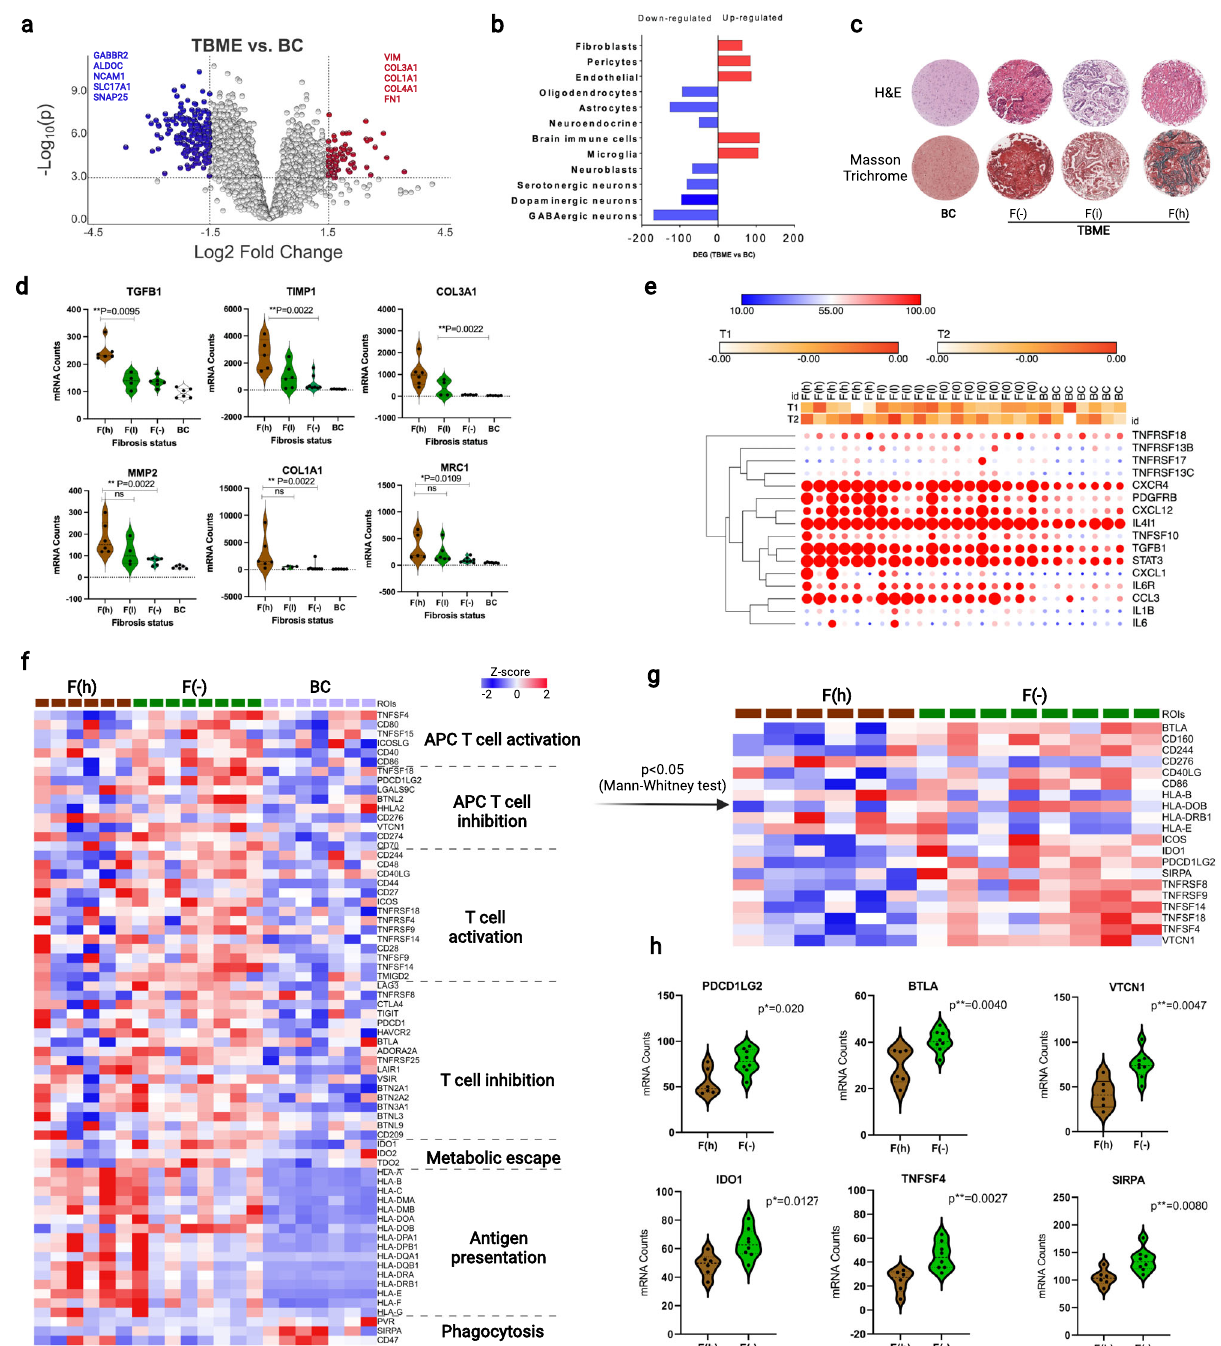
Fig.4|Thetumorbrainmicroenvironmentis fi broticandimmunosuppressed. a VolcanoplotofdifferentiallyexpressedgenesbetweentheTBMEandBC. P values were obtained from the Student t test (two-sided). b Estimated changes in cell populations between the TBME and BC based on expression of cell-speci fi c genes, n =19, 7 samples in TBME, and BC, respectively. c Representative images of H&E and Masson trichrome staining to differentiate TBME samples based on fi brosis status. F( − ) no detectable fi brosis, F(i) intermediately fi brotic TBME, F(h) highly fi brotic TBME. The scale bar is 100 μ m. d Violin plot depicting the expression of representative CAF-ECM genes. P values shown were based on nonparametric Mann – Whitney test (two-sided). The dotted lines indicate upper and lower quar- tiles, whereas the dashed lines represent medians. e Cytokine/chemokine